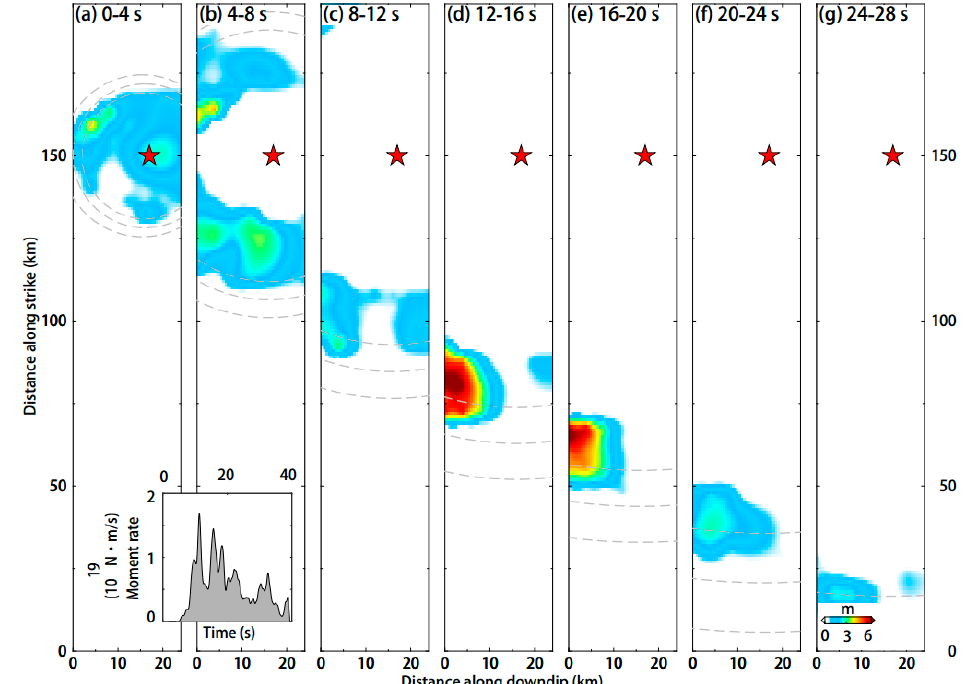
Figure 3. Snapshots of the rupture propagation. The gray dashed lines represent the reference rupture fronts moving at the 3.5 km/s, 4 km/s, and 4.5 km/s, respectively. Note that the initial rupture front went beyond the reference velocity contour of 4 km/s in the first 4 s interval, indicating a supershear rupture at the beginning of the event. The red star represents the epicenter. The moment rate function is shown in the inset map.